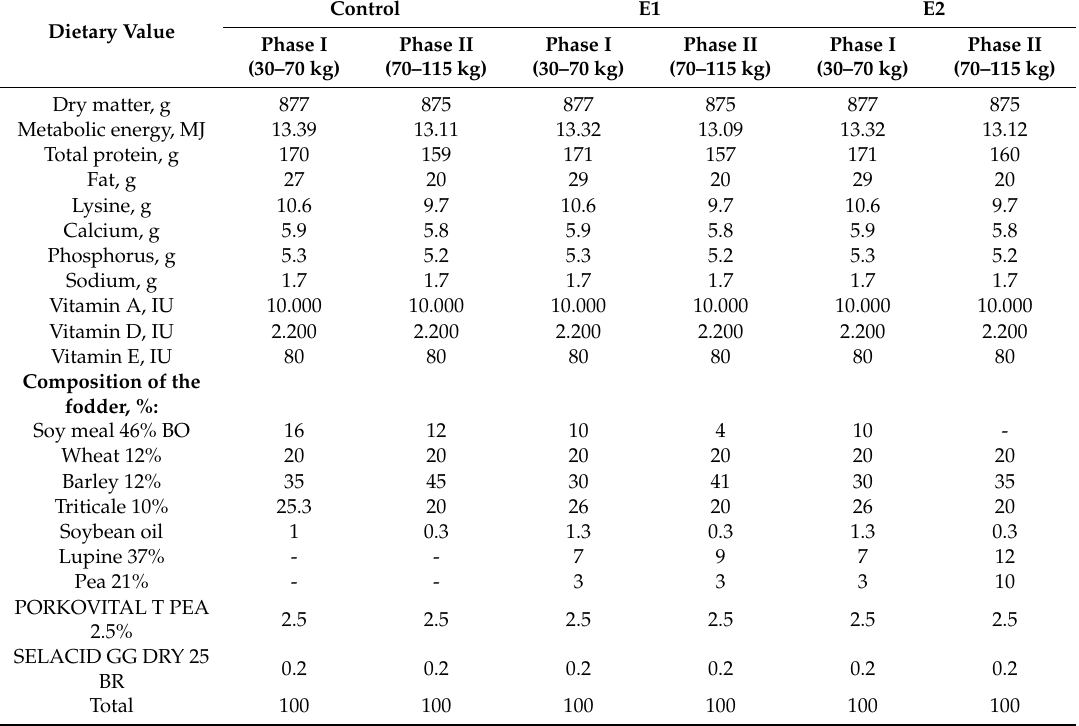
Table 1. The composition of